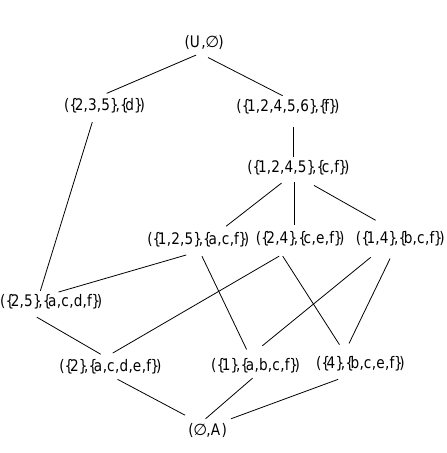
Fig.1. condition concept lattice